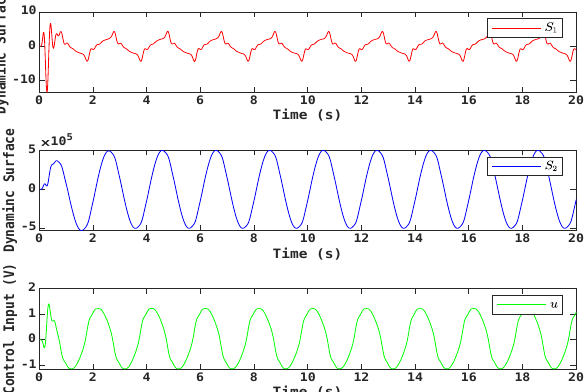
Figure 10. Dynamic surfaces and control input of the proposed control strategy in the